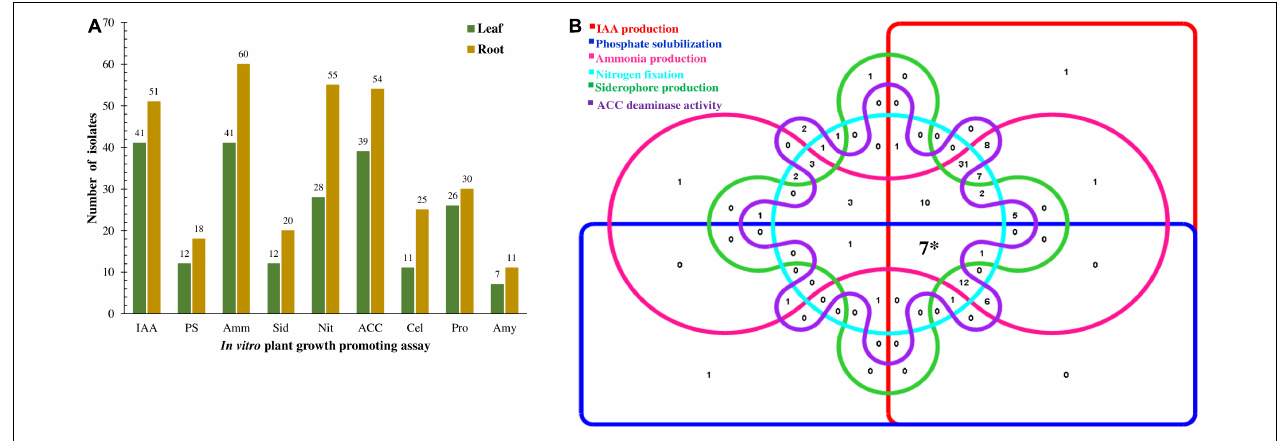
FIGURE 3 | Representation of plant growth-promoting traits showed by endophytic bacteria isolated from the tea clones. (A) Quantitative distribution of bacterial isolates according to PGP traits and isolation source and (B) Venn diagram illustrating the number of isolates showing PGP traits. The 106 isolates were allocated to 6 different PGP traits. (*7 showed PGP traits for all the attributes). TABLE 3 | Endophytic bacterial isolates with their PGP traits and general ranking for their ability to function as plant growth promoters based on bonitur scale. Isolate code Organism name Accession